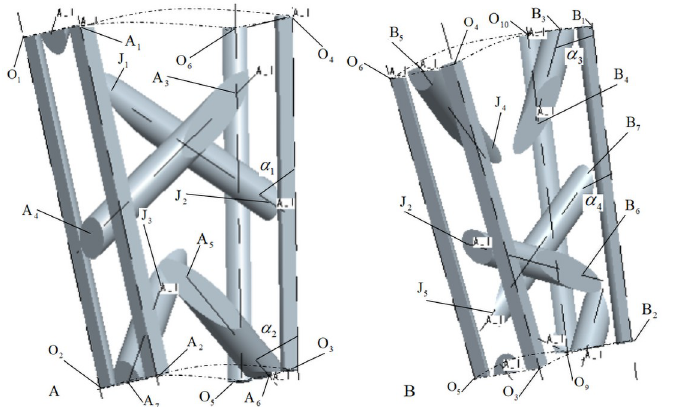
Fig 6. Position relation diagram of internal unit cells A and B.